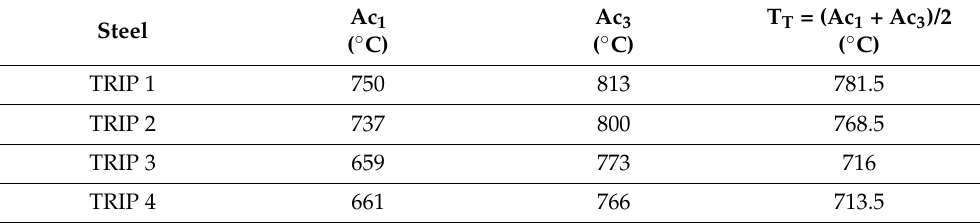
Table 3. Critical temperatures and final heat treatment temperatures of the studied TRIP steels.